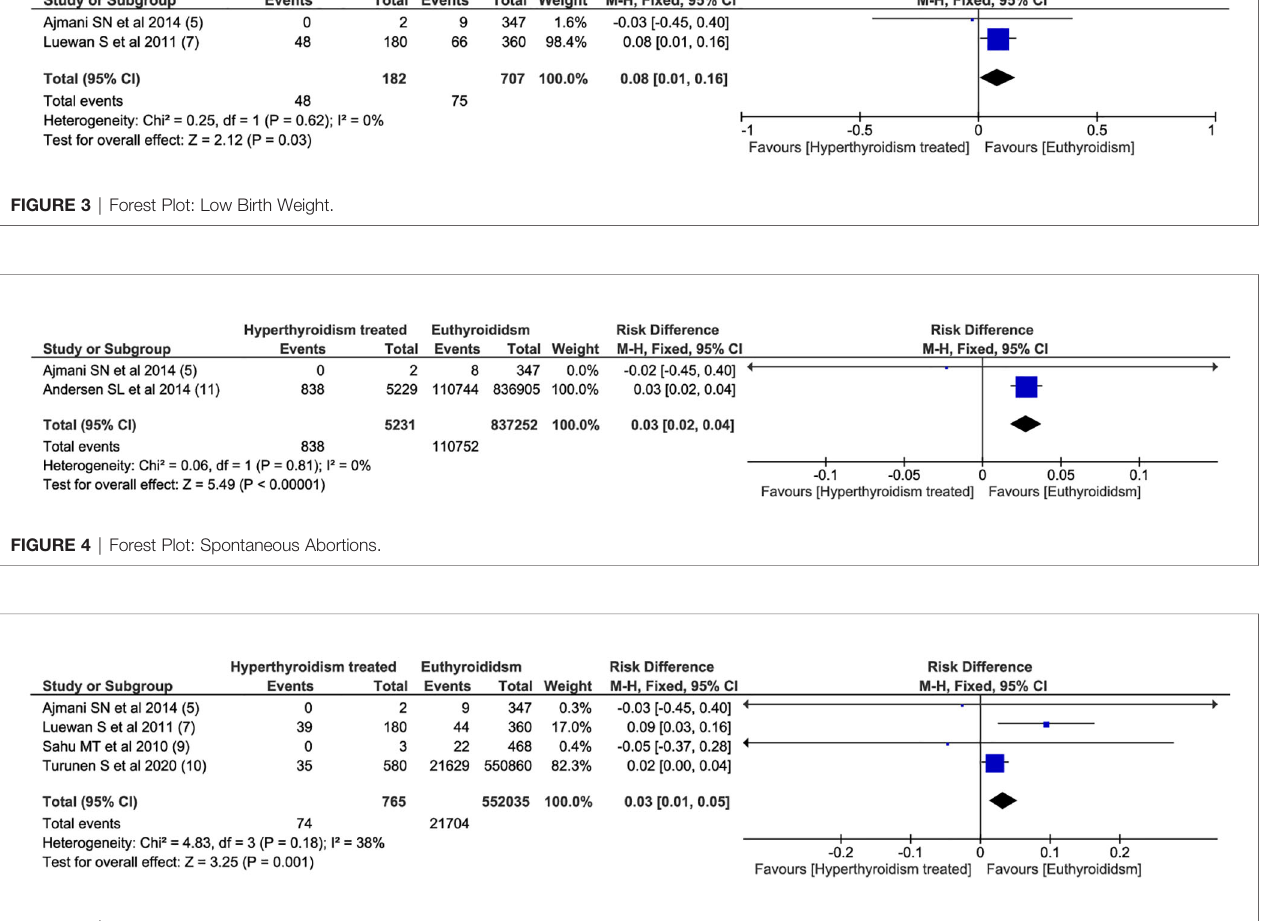
third-trimester pre-eclampsia, low birth weight, and premature birth. The mechanisms involved may be several and may be directly or indirectly related to hyperthyroidism, as discussed above. Also, other causes can be related to these negative outcomes, such as other autoimmune conditions associated